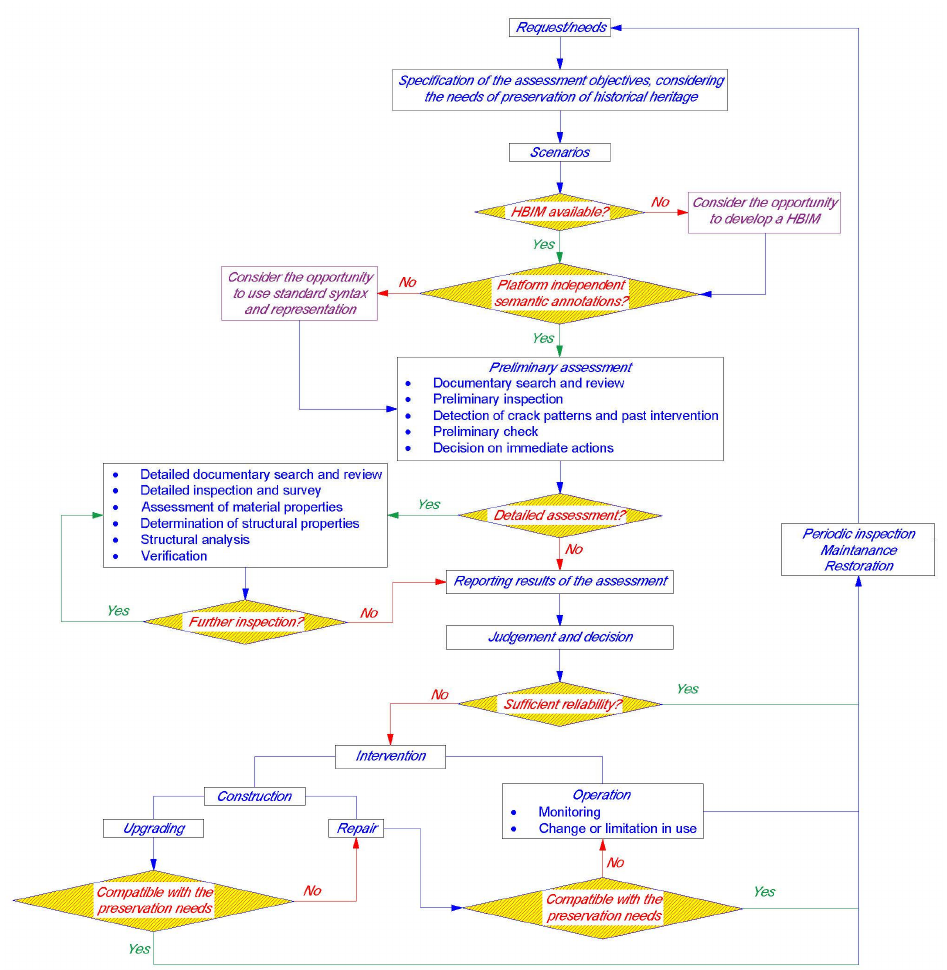
Figure 1. Flowchart illustrating the assessment procedure of heritage structures (adapted from [5]).